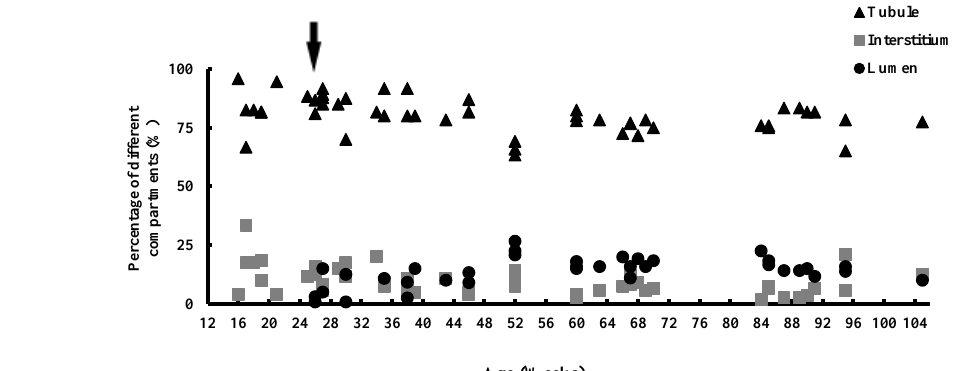
Figure 6. Percentage of seminiferous tubules, interstitial area and tubule lumen during development in individual common marmosets ( n = 48). The high percentage of the interstitial compartment until 20 weeks (5 months) of age is followed by the presence of lumen after 24 weeks (6 months) of age (arrow).